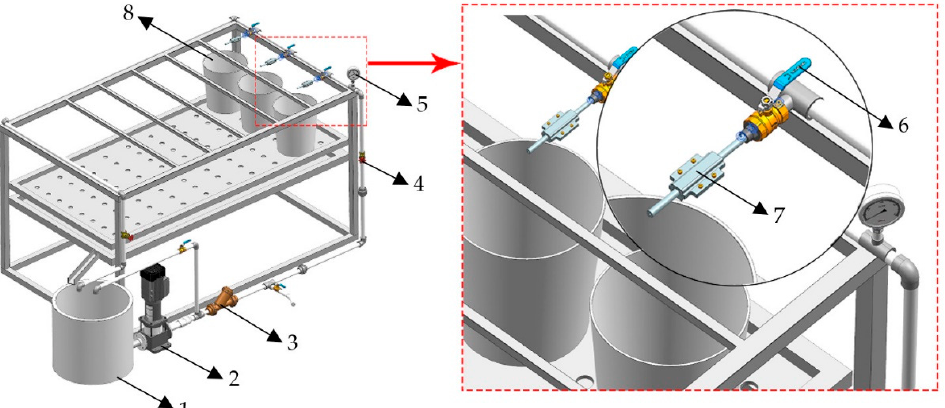
Figure 6. Schematic diagram of the variable flow emitter and testing device made by the computerized numerical control technology. Note: 1. Teflon elastomer; 2. Core body; 3. Special test equipment; 4. Screw; 5. Nut.